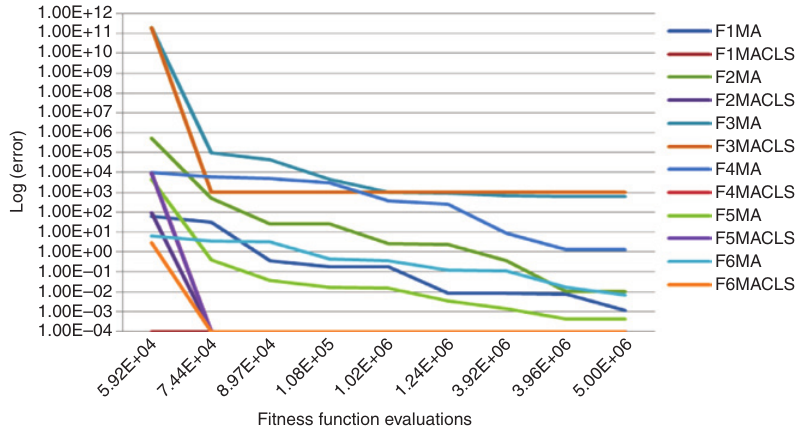
Figure 4: Convergence Rate of MA and MACLS for 1000 D .